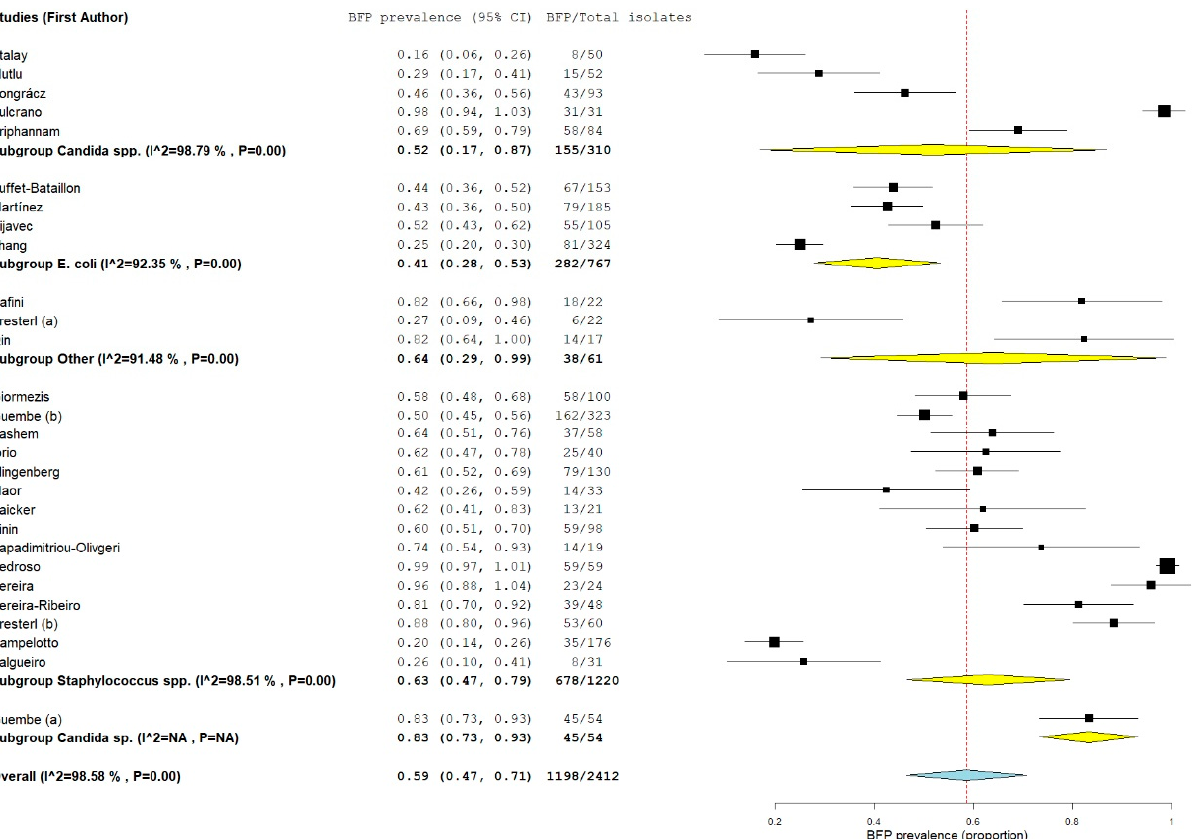
Figure 2. Forest plot of BFP (biofilm production) prevalence and subgroup analysis by microorganism “P” represents the p -value. The “I 2 ” statistic describes the percentage of variation across studies that is due to heterogeneity rather than chance, where “CI” stands for confidence interval.